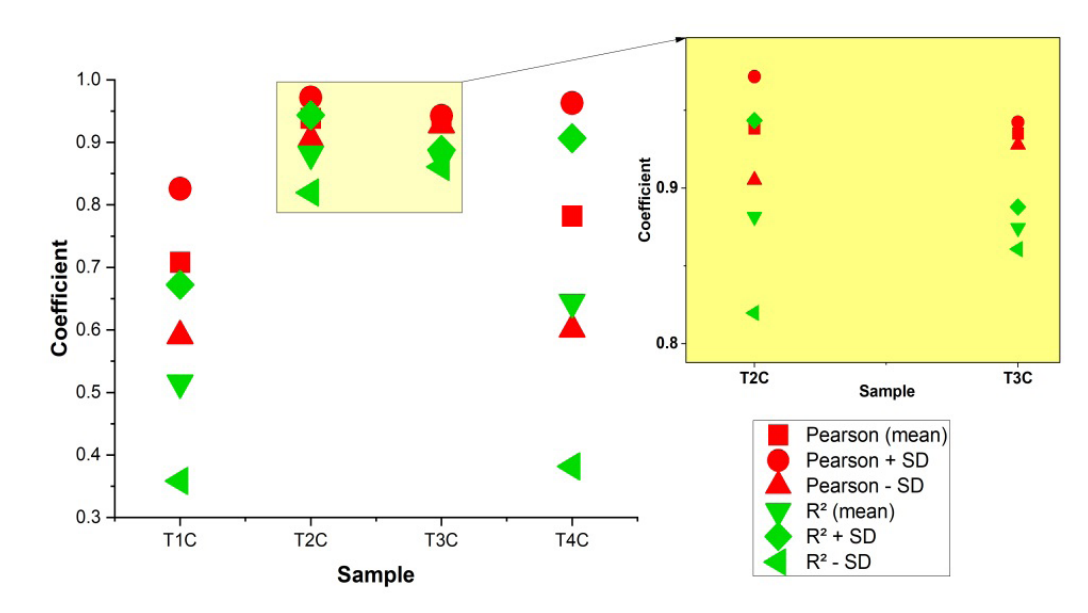
Figure 12. Mean and standard deviation per sample for each type of coefficient (r and R 2 ).